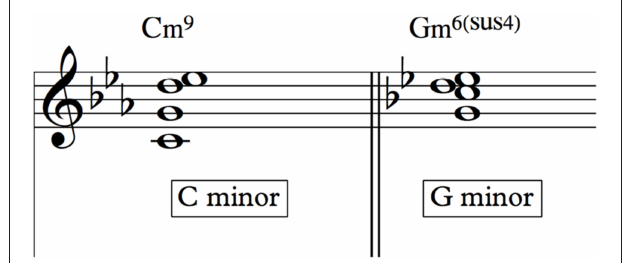
FIGURE 4 | Depending on the context, identical sets of notes can assume different functions and, as consequence, different names. In the figure we see the chord made of the notes [C, D, Eb, G]: this chord can be called C minor 9th in the context of the key of C minor and G minor sus4 6th in the context of the key of G minor. Note that this is not a simple change of function: in this case not only the function is different but also the very name of the chord. This ambiguity can be a problem in the context of data labeling, where different experts could assume different hypothesis on the context thus leading to different